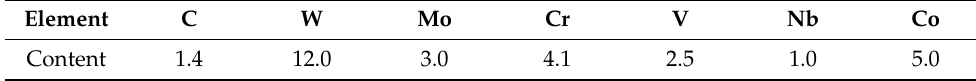
Table 1. Chemical composition of T15MN HSS